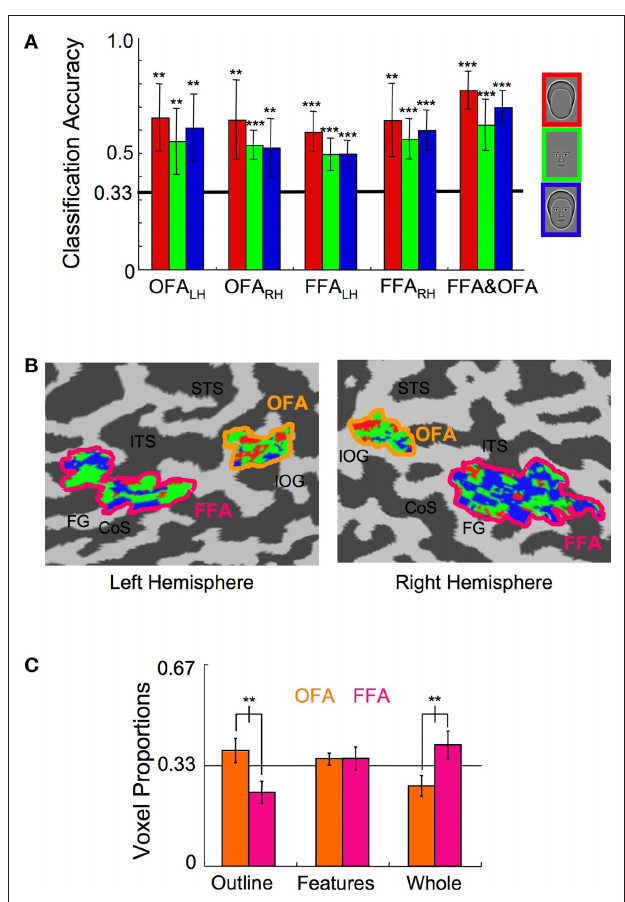
Figure 6 | experiment 1 results. (A) The multi-class SVM analysis within specific ROIs indicates that classification of each stimulus category was significantly above chance in both hemispheres of the OFA and FFA (error bars, 95% c.i.). (B) The color-coded distributions of voxels according to the stimulus category to which they maximally contributed are shown here on the flat map of face-sensitive cortex from a representative subject. Anatomical labels are as follows: superior temporal sulcus (STS), inferotemporal sulcus (ITS), inferior-occipital gyrus (IOG), collateral sulcus (CoS), fusiform gyrus (FG). (C) The relative proportion of voxels that maximally contributed to the three stimulus categories within the OFA and the FFA (error bars, 95% c.i.). Asterisks indicate the level of significance for independent t -tests in (A) and paired t -tests in (C) (* p < 0.05, ** p < 0.01, *** p <